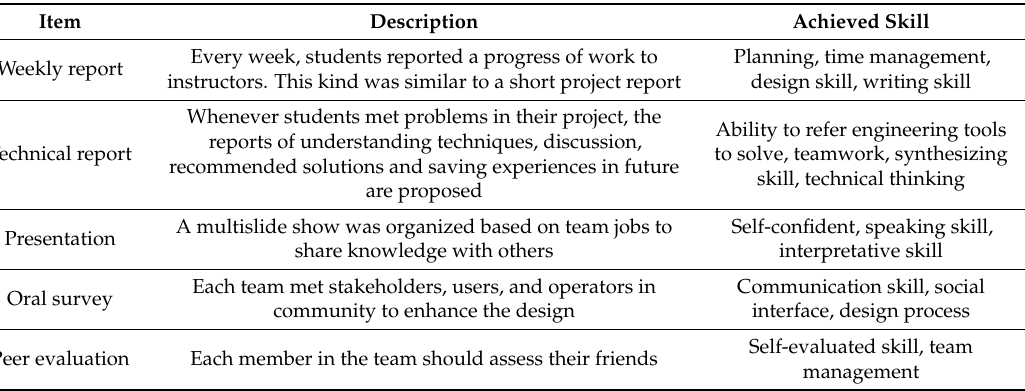
Table 4. Lists of direct assessment